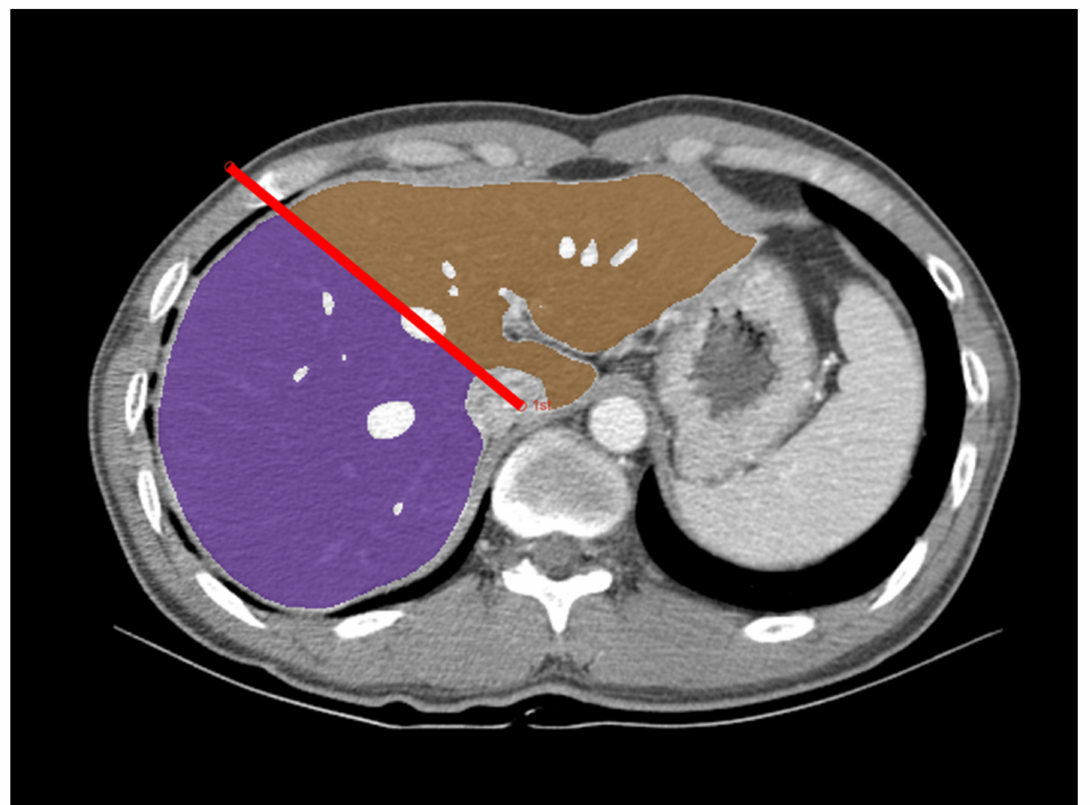
Figure 2. Measurement of the right-lobe graft volume using deep-learning-algorithm-assisted CT volumetry. An axial portal venous phase CT image in a 44-year-old male donor is overlaid with a right-lobe mask (purple), a left lobe mask (brown), and a dividing line (red line). CT image data were first processed by the deep learning algorithm for whole liver segmentation. The radiologist reviewed these results, corrected any segmentation errors, and defined the resection plane for the right-lobe graft by drawing the dividing